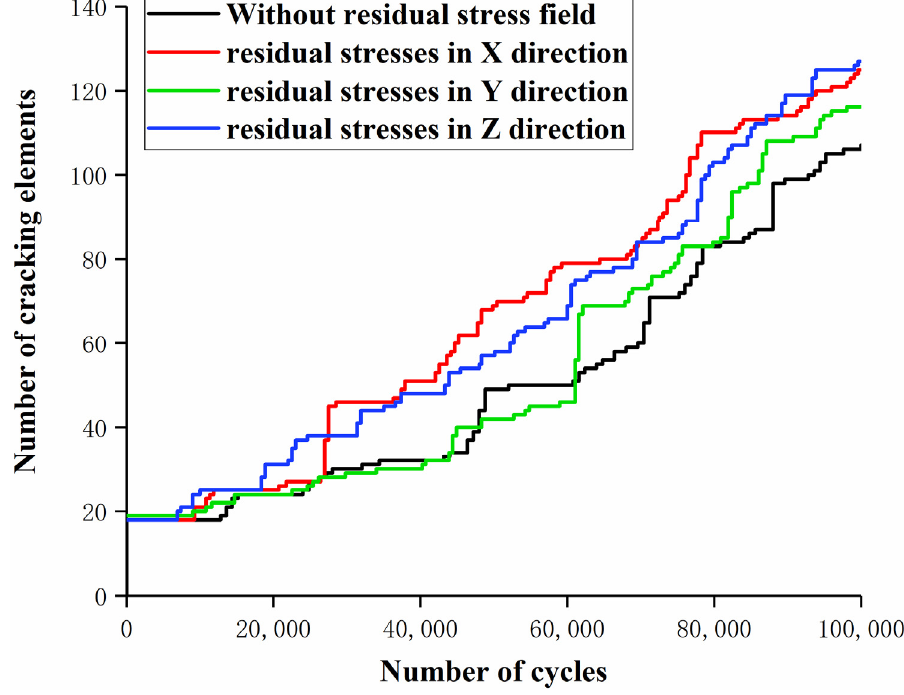
Figure 28. Crack expansion rate under the influence of anisotropic residual stress.